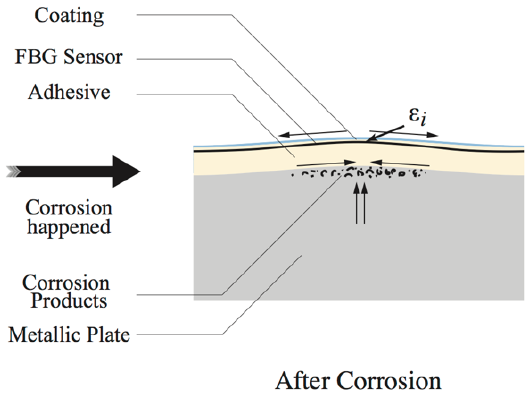
Figure 1. Cross-section of embedded FBG sensors based corrosion monitoring system.